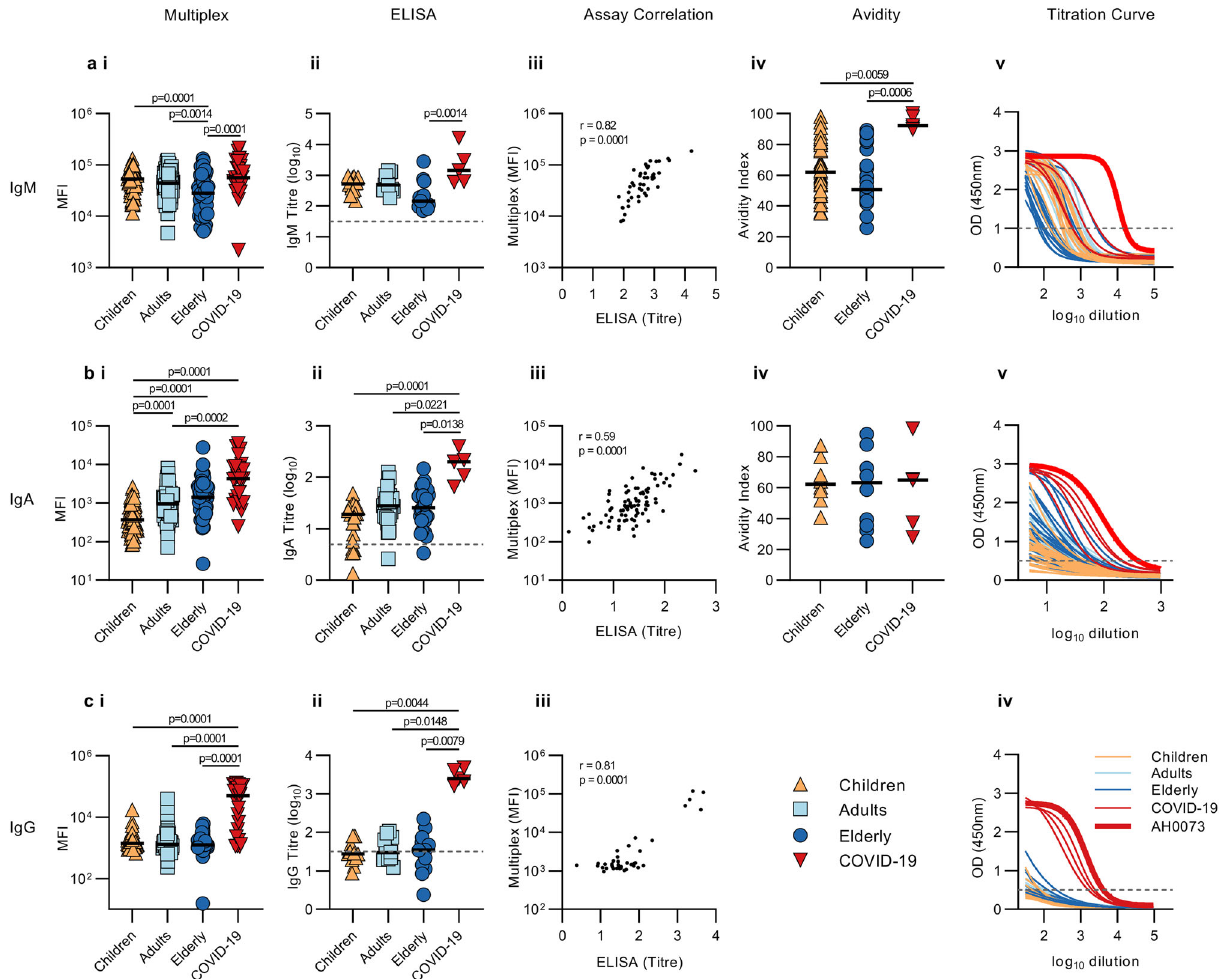
Fig. 5 Receptor binding domain Abs in healthy versus COVID-19 patients. Multiplex MFI data for IgM ( a -i), IgA ( b -i) and IgG ( c -i); ELISA endpoint titres for IgM ( a -ii), IgA ( b -ii) and IgG ( c -ii); and their respective correlations ( a – c iii). Avidity index following urea dissociation for IgM ( a -iv) and IgA ( b -iv). Children (orange), adults (light blue), elderly (dark blue) and COVID-19 patients (red). Bar indicates the median response of each group. Statistical signi fi cance was determined using one-way ANOVA (Kruskal-Wallis with Dunn ’ s multiple comparisons), exact p -values were provided. Serial dilutions of plasma from healthy children ( n = 14) (orange), 12 adults ( n = 12) (light blue), 14 elderly ( n = 14) (dark blue) and 5 COVID-19 patients (red) tested in IgM ( a -v), IgA ( b -v) and IgG ( c -iv) ELISA. Bold red line represents COVID-19 patient AH0073 who was used as a positive control in all multiplex and ELISA plates. Dashed lines represent cut-offs (15% of positive control for IgA and IgG; 30% for IgM) used to interpolate endpoint titres by non-linear regression analysis. ELISA and multiplex assays were repeated in